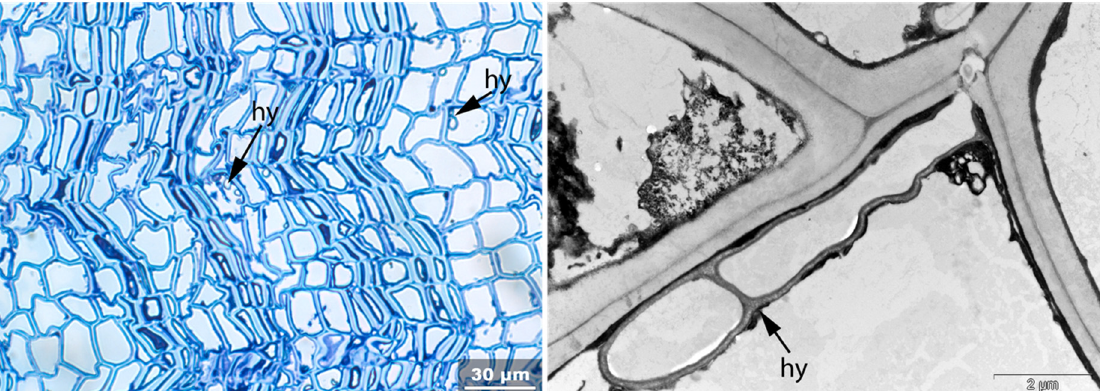
Figure 24. Sample 11. Left: LM. Hypha present in lumen of thin-walled cells distributed over entire thin section. Hyphae are aligned along tertiary wall and cause reduced thickness. Right: TEM. Division of hyphae into two cells (septum) is present. Defects are visible in a corner of the secondary cell wall and the middle lamella, possibly caused by hyphae.